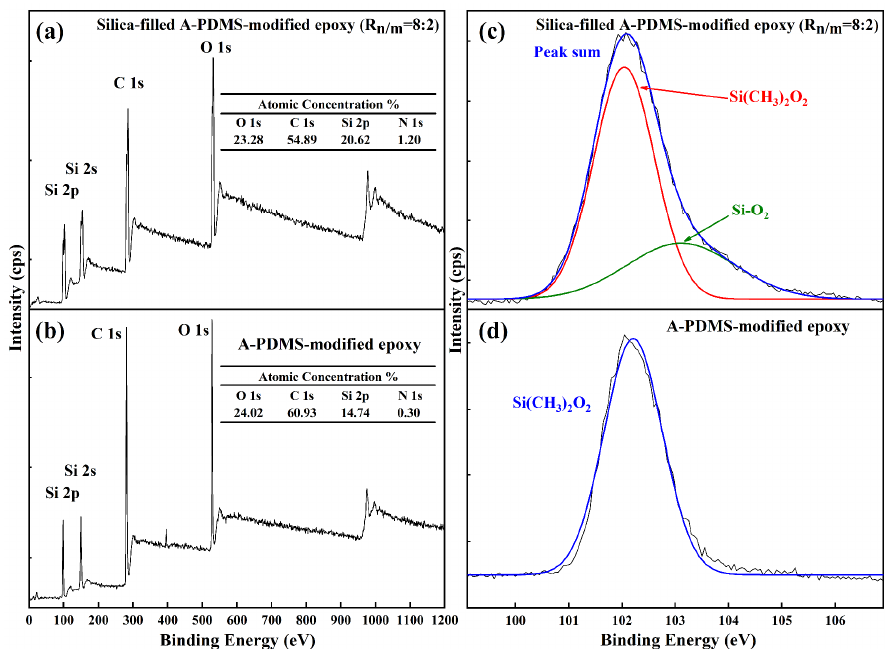
Figure 7. The wide-scan XPS spectrum of the ( a ) nano / microsilica-filled A-PDMS-modified epoxy coating ( R n / m = 8:2) and the ( b ) A-PDMS-modified epoxy with no silica. Atomic concentrations are shown in the insets. ( c ) High-resolution XPS spectrum of Si 2p of the nano / microsilica-filled A-PDMS-modified epoxy coating ( R n / m = 8:2) and the ( d ) A-PDMS-modified epoxy with no silica.